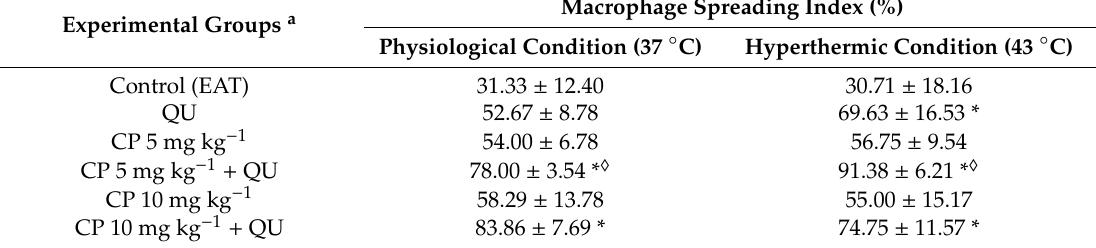
Figure 6. Changes in Polymorphonuclear/Mononuclear Leukocyte Ratio—P/M activity of Swiss albino mice bearing Ehrlich ascites tumor after therapeutic treatment with QU and cisplatin under physiological and hyperthermic conditions at day 13 ( A ) and day 20 ( B ). Mice were treated with CP (5 or 10 mg kg − 1 , i.p. ) 5th day after i.p. inoculation of EAT cells (2 × 10 6 /mouse) under physiological and hyperthermic conditions and with QU ( i.p. 50 mg kg − 1 ) at day 6 and 12 after i.p. inoculation of EAT cells. The results are expressed as mean value of each experimental group ( n = 6). Abbreviations: QU—treatment with quercetin at a dose of 50 mg kg − 1 ; CP5 or CP10—treatments with cisplatin at doses of 5 or 10 mg kg − 1 ; P—polymorph nuclear leukocytes; M—mononuclear leukocytes; P / M—ratio between polymorph nuclear leukocytes and mononuclear leukocytes. Table 6. Macrophage spreading index in peritoneal cavity of Swiss albino mice bearing Ehrlich ascites tumor after therapeutic treatment with cisplatin and QU under physiological and hyperthermic condition.